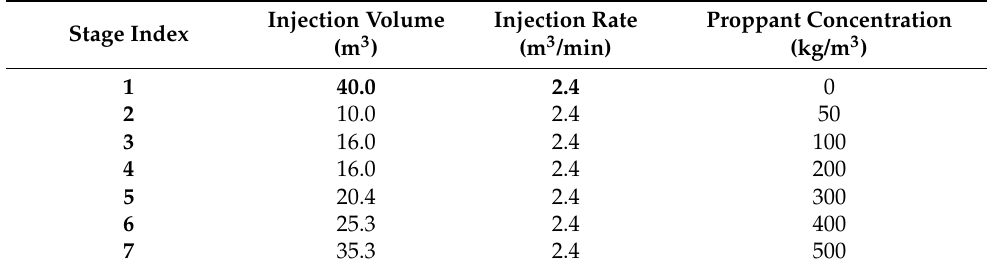
Table 2. Pumping schedule used for the validation with Fracpro PT software. The stage index refers to the sequence of injected